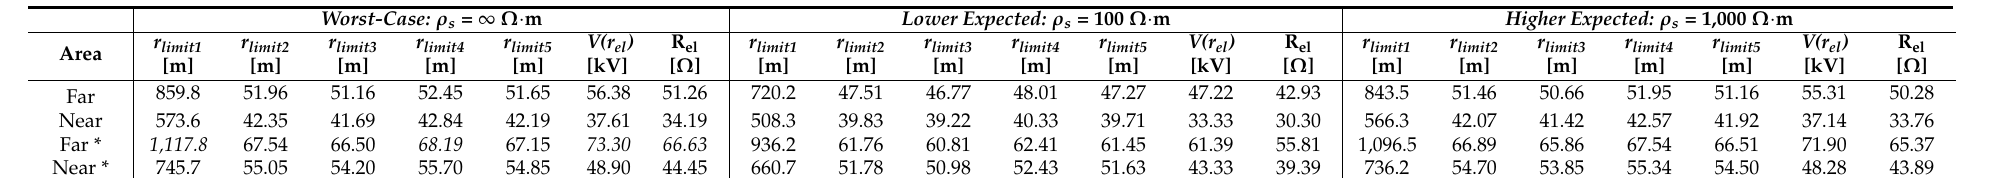
Table 3. Minimum values of distances for absolute potential in relation to remote earth, for potential gradient/electric field strength in steady and transient state, absolute potential at electrode surface and equivalent electrode resistance in the area of Korakia (Crete) in relation to neighboring coasts based on method “A” according to Equations (8) and (9), (74), (76) and